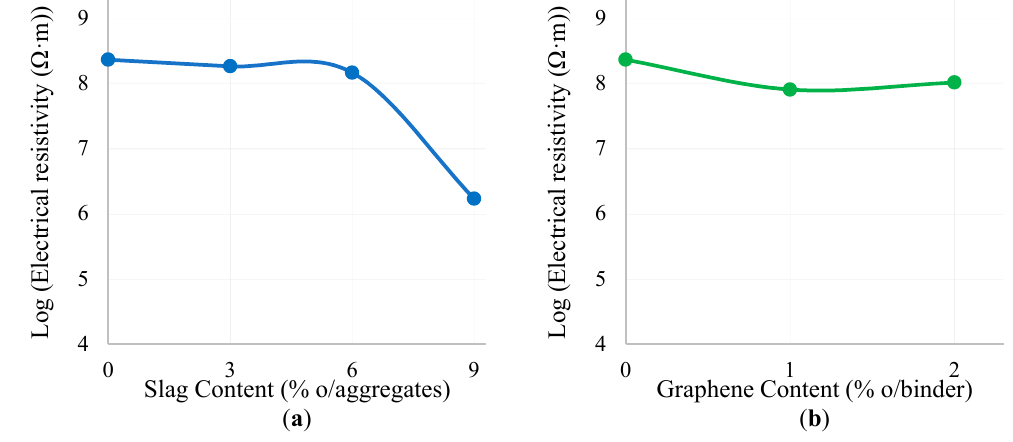
Figure 12. Effect of slag ( a ) and graphene ( b ) on the electrical resistivity.